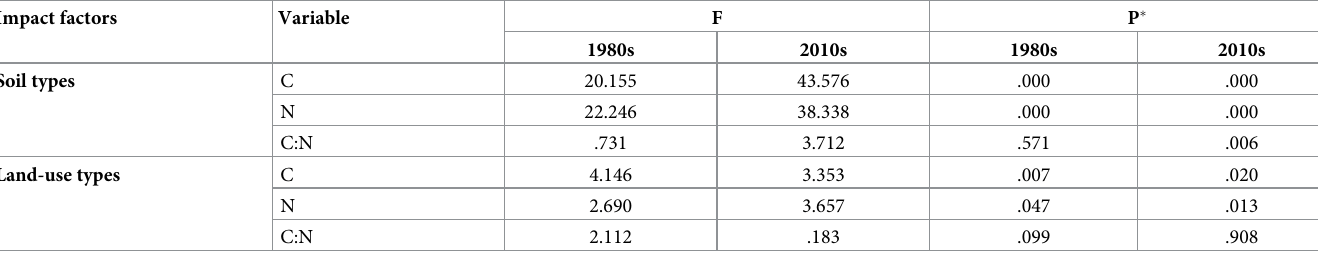
Table 4. Significance test of soil types and land-use types on C, N contents and C:N stoichiometry. Impact